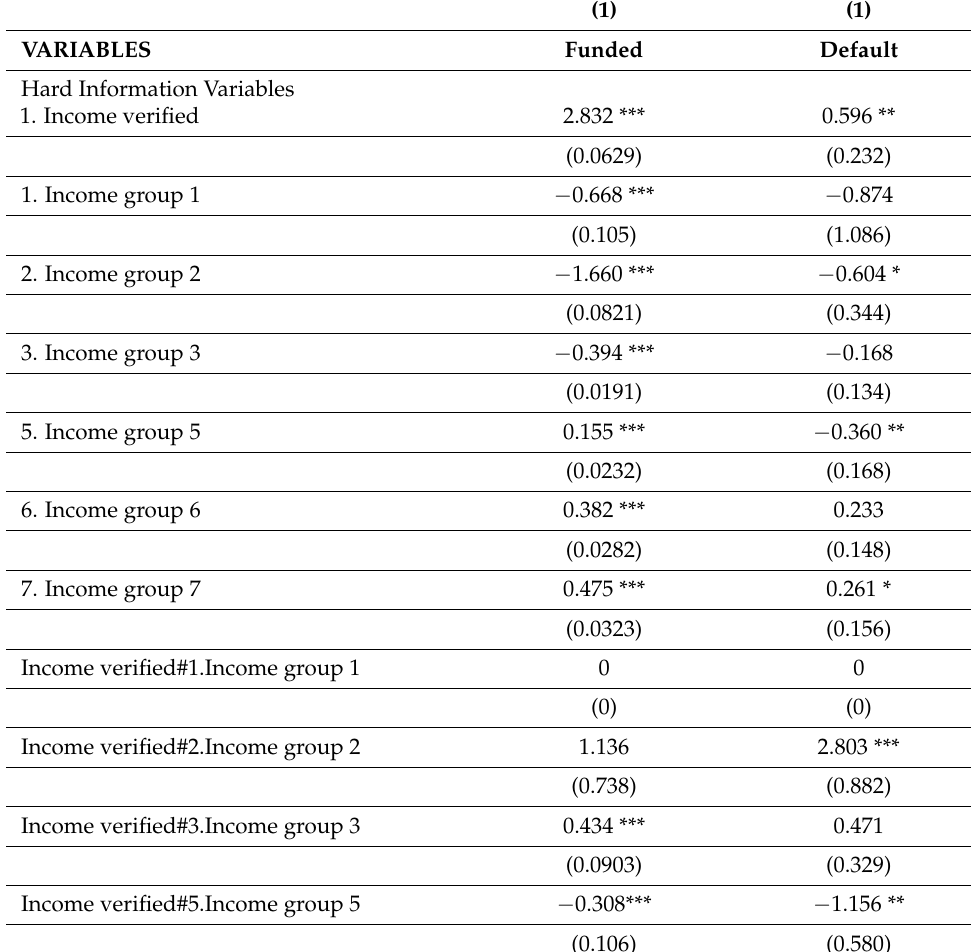
Table 2. Comparison of Logit Regression Results for Funding Probability and Default Predicting